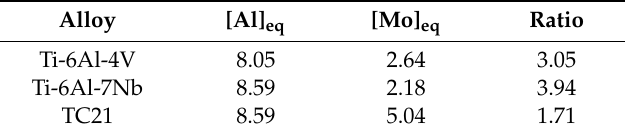
Table 3. and [Mo] eq for the investigated alloys [26,27]. Alloy [Al]